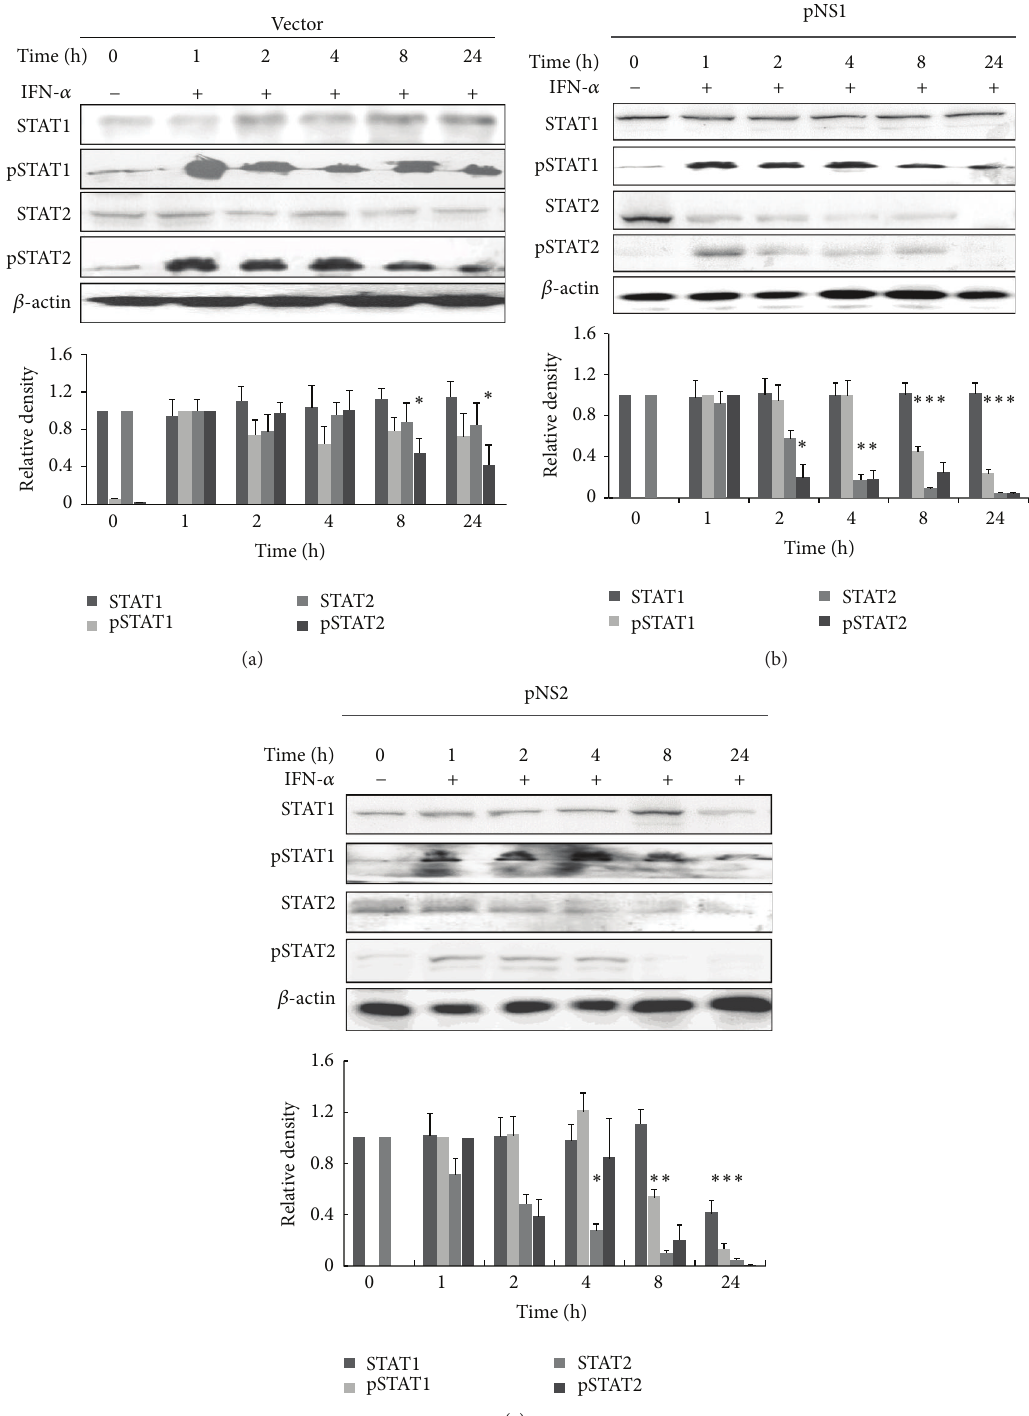
Figure 3: Expression of RSV NS proteins resulted in impaired IFN- 𝛼 -induced STAT phosphorylation. A549 cells were incubated with or without IFN- 𝛼 (5000 U/mL) for 30 min and then transfected with empty vectors (a), pNS1 (b), or pNS2 (c) for the indicated times. Total protein lysates were subjected to Western blot analysis using the following antibodies: anti-pSTAT1 (1: 1000), anti-STAT1 (1:1000), anti- pSTAT2 (1:1000), or anti-STAT2 (1:1000). The results shown are representative of three independent experiments. The data were analyzed by densitometry, normalized to 𝛽 -actin protein levels, and are shown as the mean ± SE. ∗ 𝑝 < 0.05 versus untreated